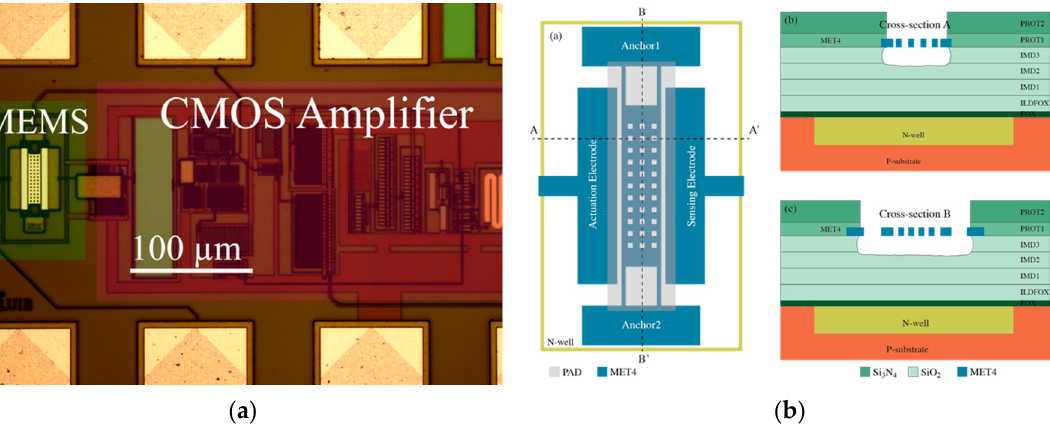
Figure 2. ( a ) Optical image of the overall CMOS-MEMS oscillator circuit fabricated in CMOS 0.35 µ m commercial technology. ( b ) Schematic diagram showing the side-view of the MEMS resonator for two cross-sections.